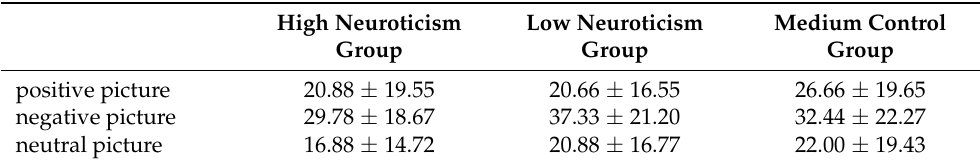
Table 6. Descriptive statistics of the three types of emotional pictures. ( M ± SD ; Unit: